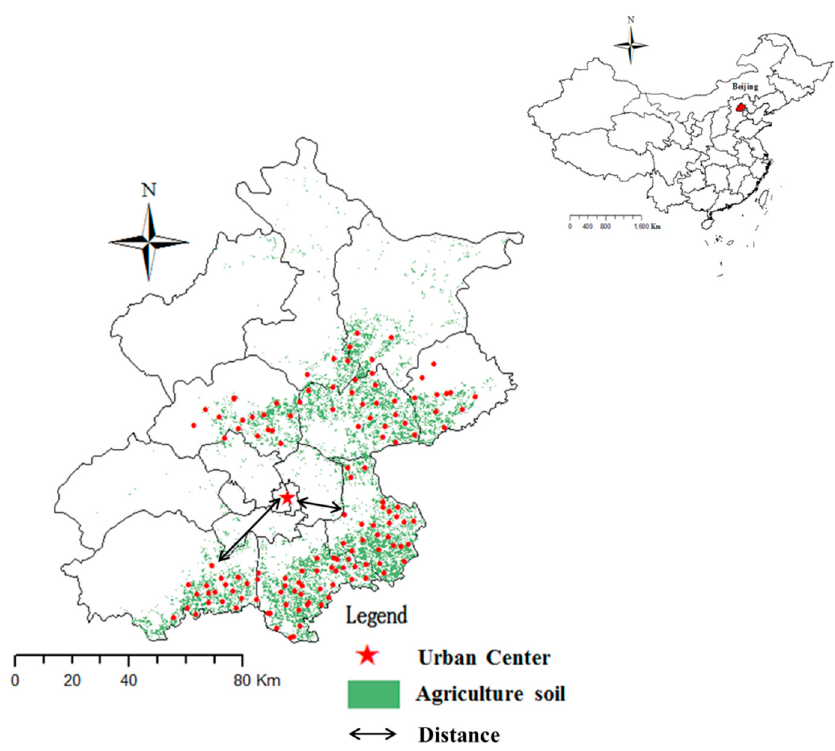
Figure 1. The agricultural soil sampling sites in the Beijing.